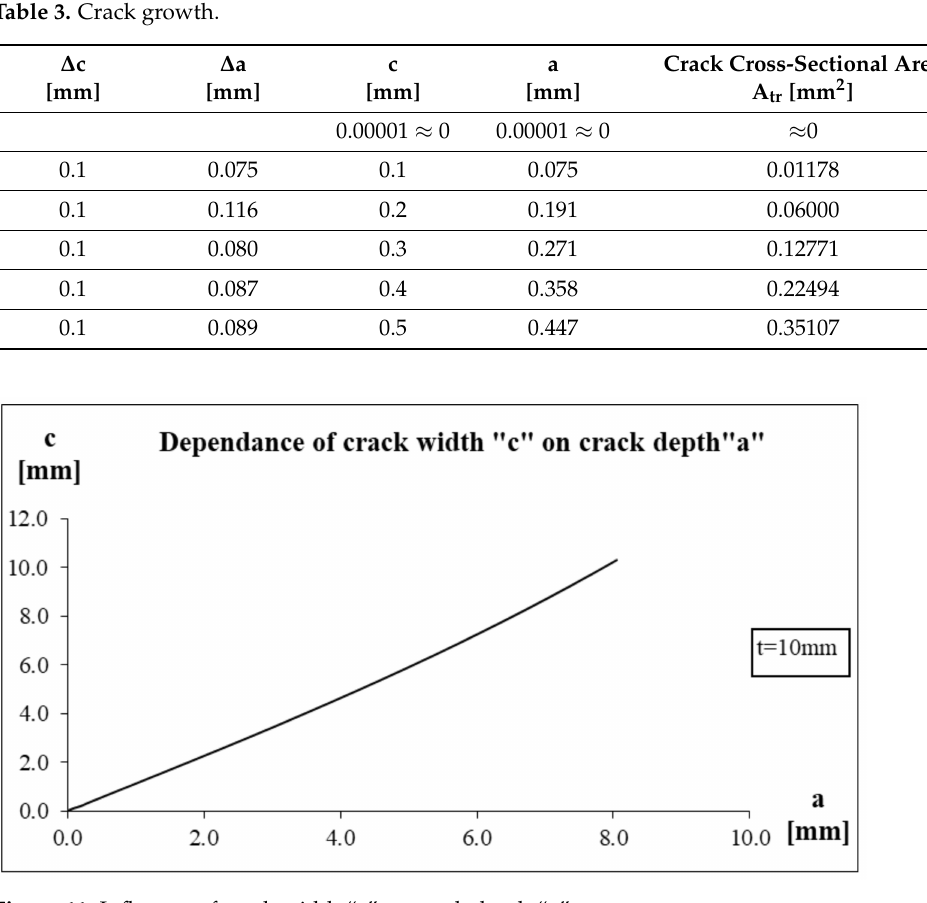
Figure 11. Influence of crack width “c” on crack depth